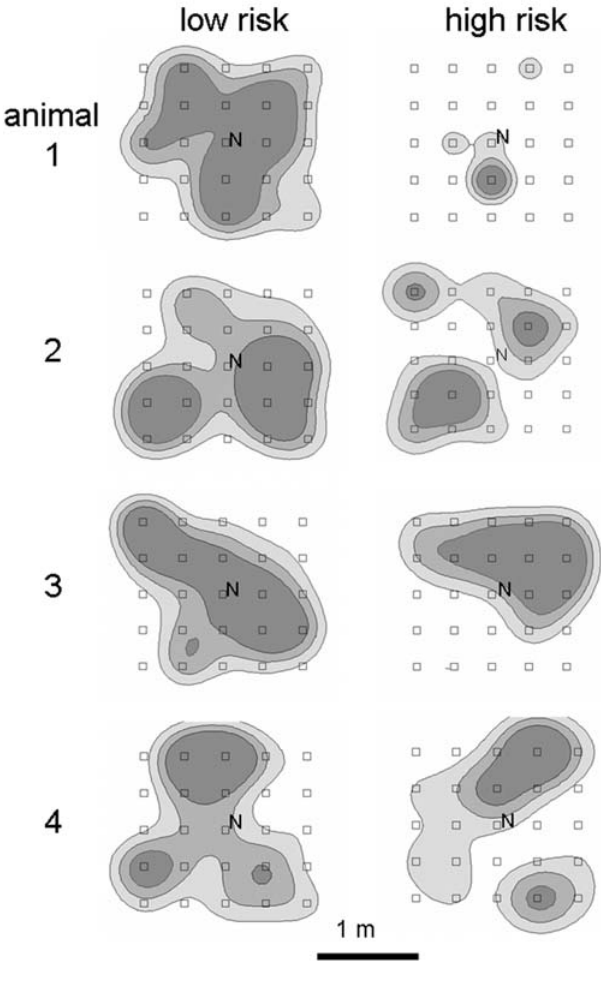
Figure 3. Spatial distribution of time investment. Four exemplary foragers (male bank voles) at their first day of foraging under safe (left) and risky (right) conditions. Investment is displayed as Kernel contour cores 50% (darkest), 75% (lighter) and 95% (lightest shade) based on location density (time investment) and distance between locations.